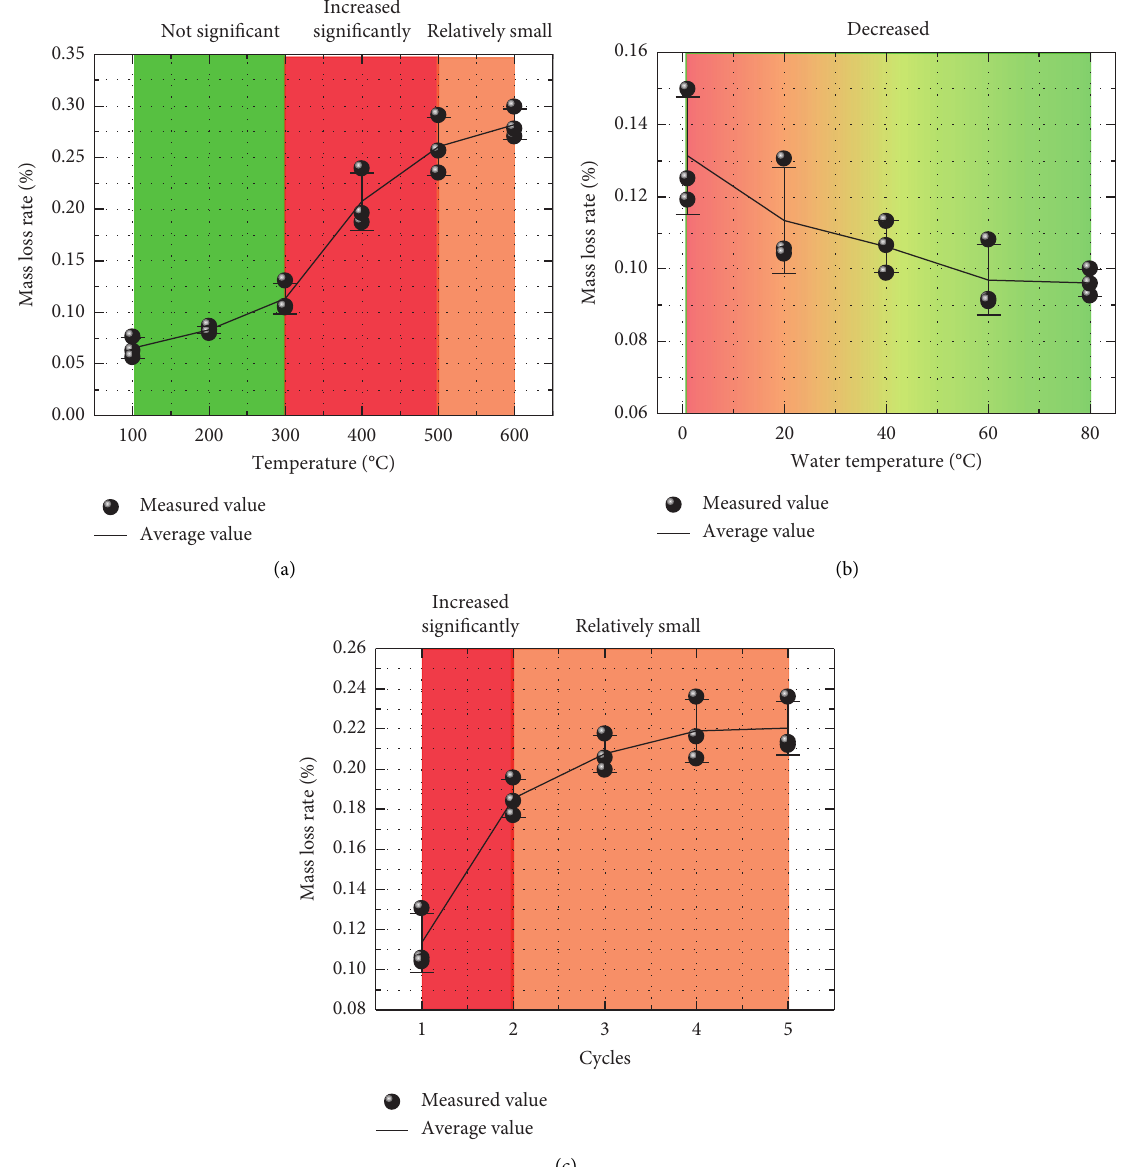
Figure 5: Mass loss rate of specimens subjected to different conditions of water cooling at high temperatures. (a) HDR temperature. (b) Water temperature. (c) The number of heating-cooling